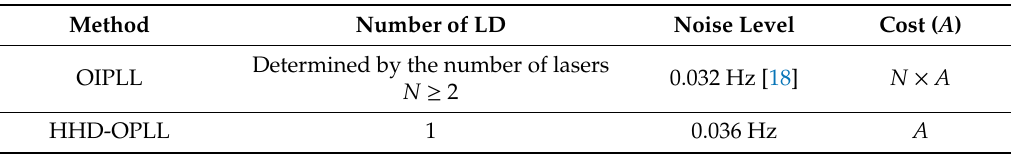
Table 1. Comparison of the optical injection phase-locked loop (OIPLL) and the homologous heterodyne digital optical phase-locked loop